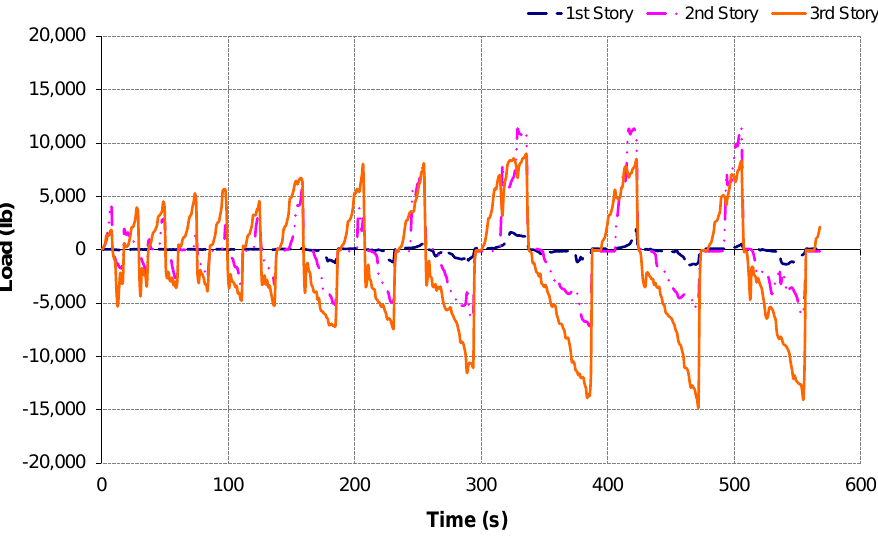
Figure 22. Half-brace cyclic test HBCT2 load